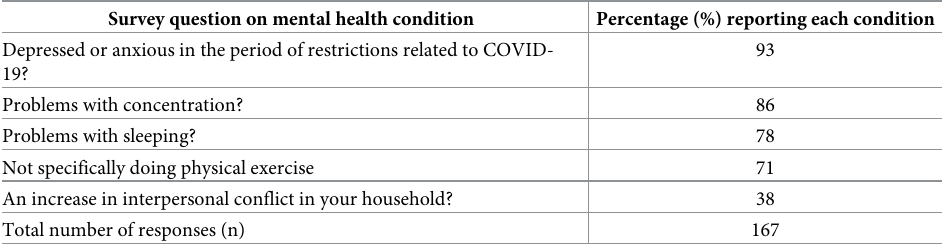
Table 5. Mental health responses of those who could not maintain overall wellbeing, South Australia 2020. Survey question on mental health